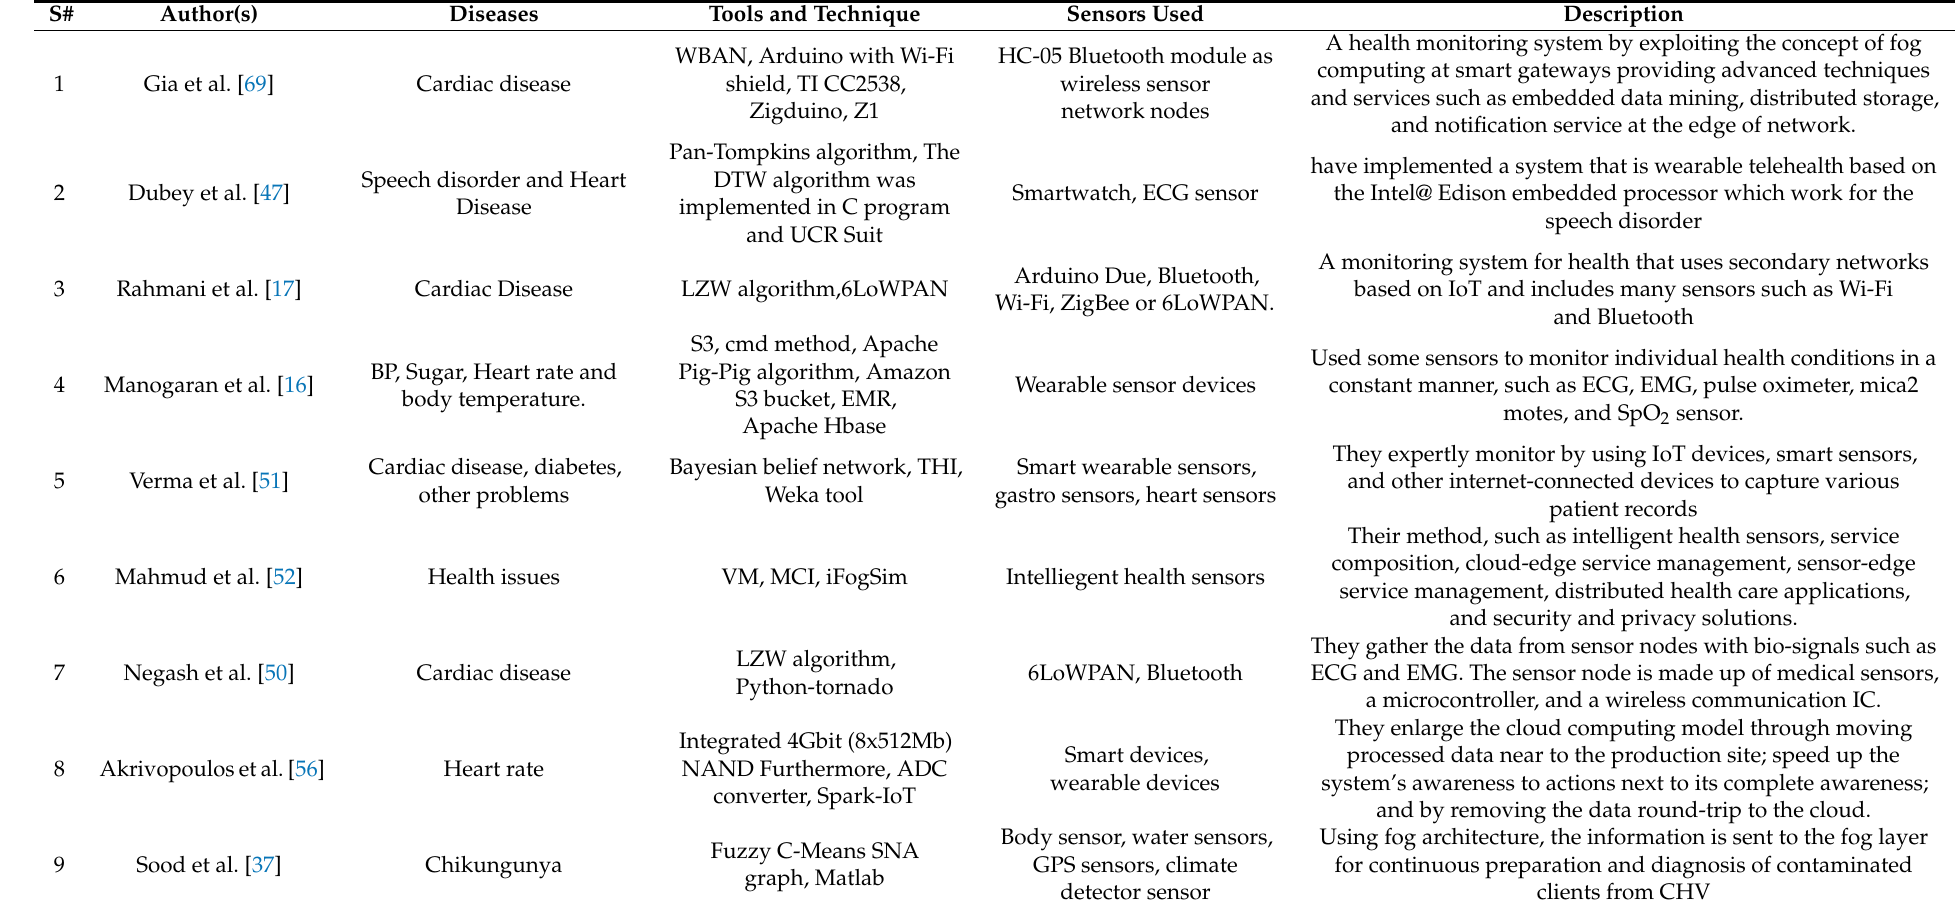
Table 1. Comparative analysis of various healthcare